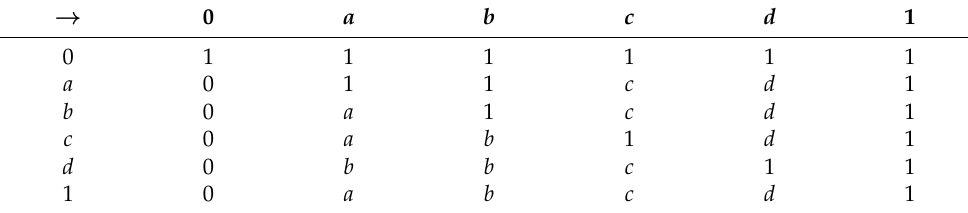
Table 4. The operation →